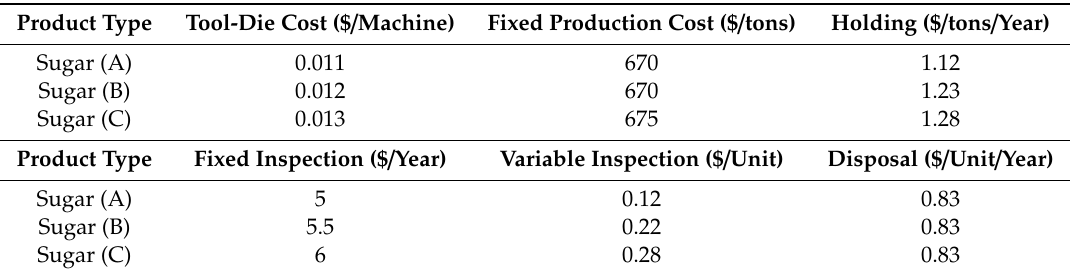
Table 3. Vendor data to process various grades of